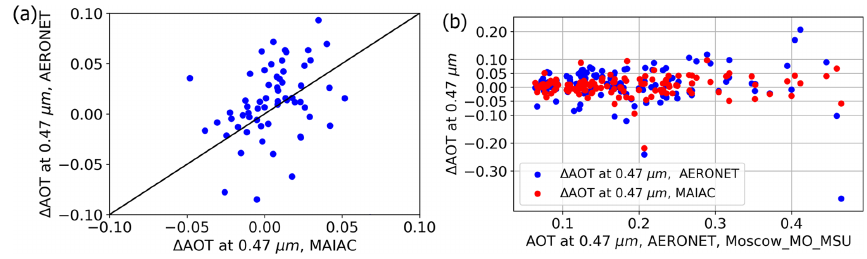
Figure 5. (a) Relationship between (cid:49) AOT at 0.47µm ( (cid:49) AOT = AOT Moscow_MO_MSU − AOT Zvenigorod ) obtained from the satellite and ground-based data; (b) (cid:49) AOT at 0.47µm as a function of AOT at 0.47µm obtained from the Moscow_MSU_MO dataset.